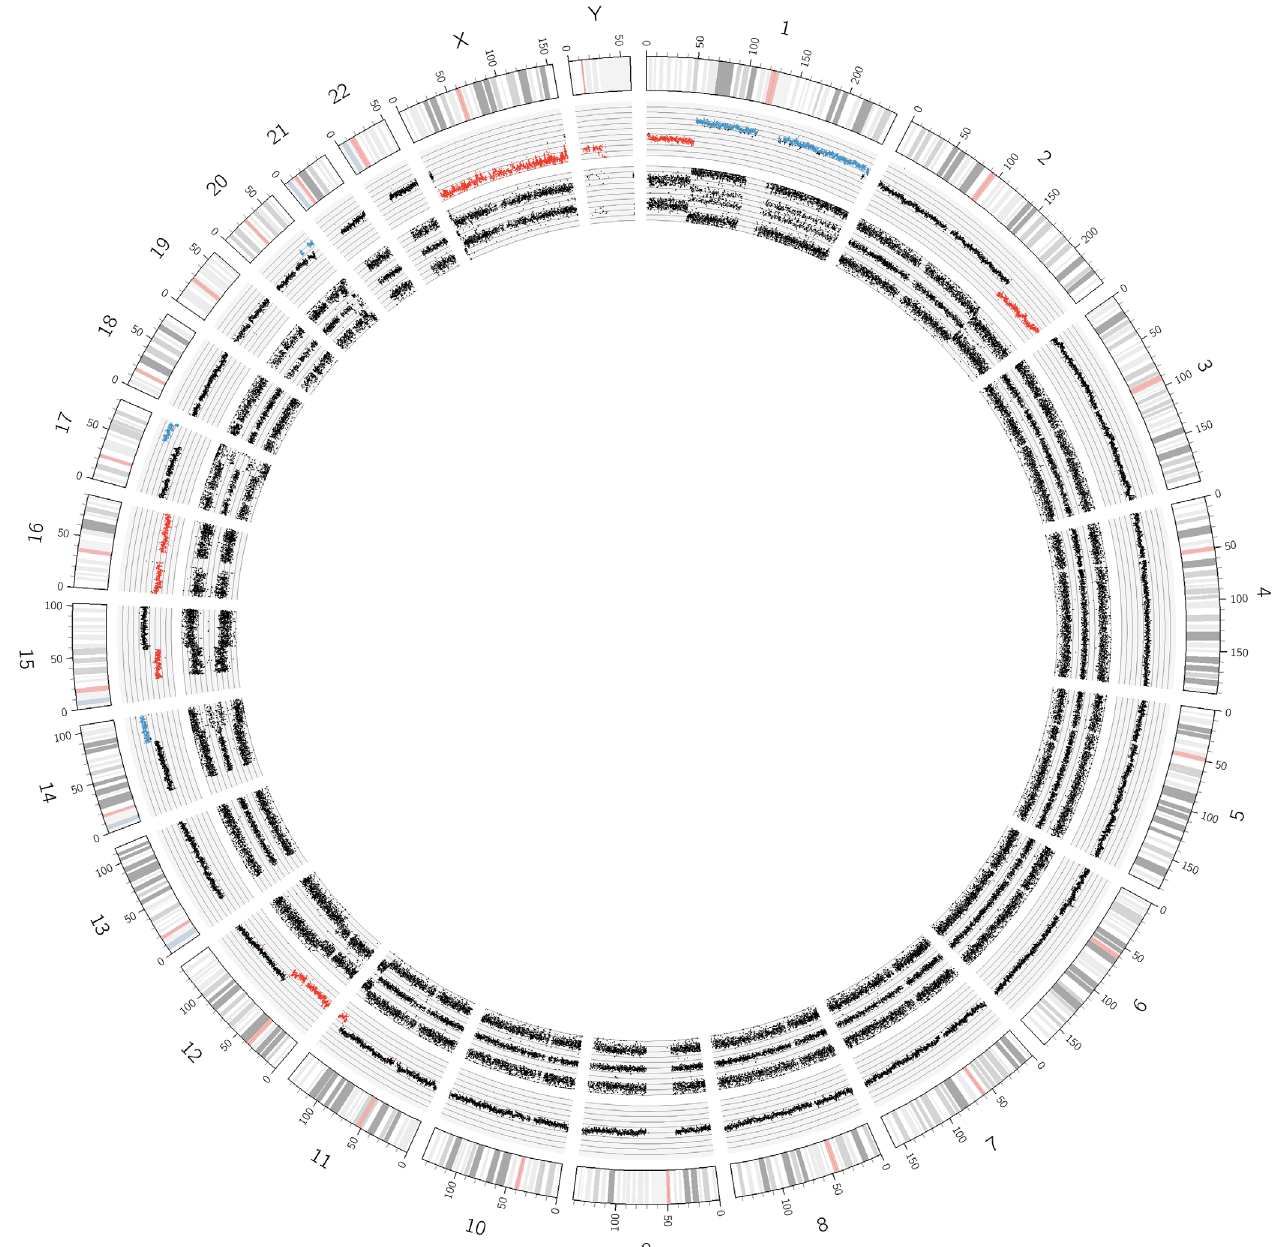
Fig 2. Circos Plot of copy number and SNP probe data for sample NB05. The tracks are from outside inwards: chromosome numbers, chromosomal positions in Mb, copy number and allele patterns. Copy number gains and losses are shown in blue and red, respectively. SCAs resulting in deletion of the concerned region where seen at 1p, 2q, 11q, 12p/q and 15q. Gains were found at: 14q, 17q and 20q. Chromosomes 12 and 15 show partial UPDs in addition to the before mentioned deletions. Chromosome 16 discloses a monosomy with a typical two band allele pattern (allele configurations A0 and B0). Most autosomes (3, 4, 5, 6, 7, 8, 9, 10, 13, 18, 19, 21 and 22) show a continuous disomic copy number profile with a normal three band allele pattern (allele configurations AA, AB and BB). A MYCN amplification is present but hardly visible at the short arm of chromosome 2 (small blue dot). The sex chromosomes show monosomies (except for the pseudoautosomal regions on the X chromosome) indicating that this profile belongs to a male patient. number of MYCN copies in single cells is equaled out by a high number of non-amplified tumor cells, resulting in a copy number status below the MYCN amplification threshold.